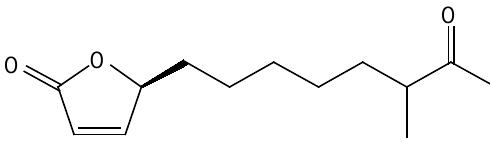
Figure 1. The structure of compound 1 .